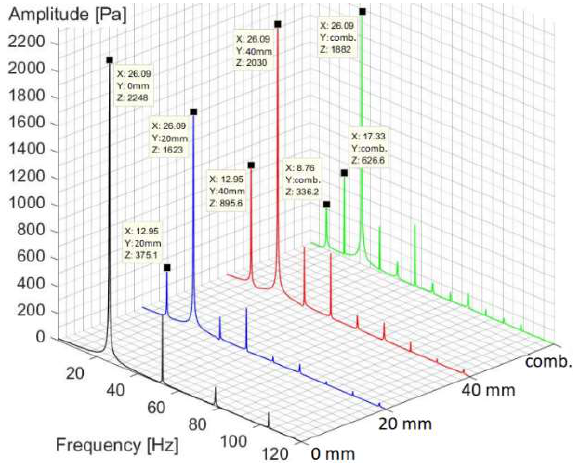
Table 4 The overview of maximum static pressure amplitudes